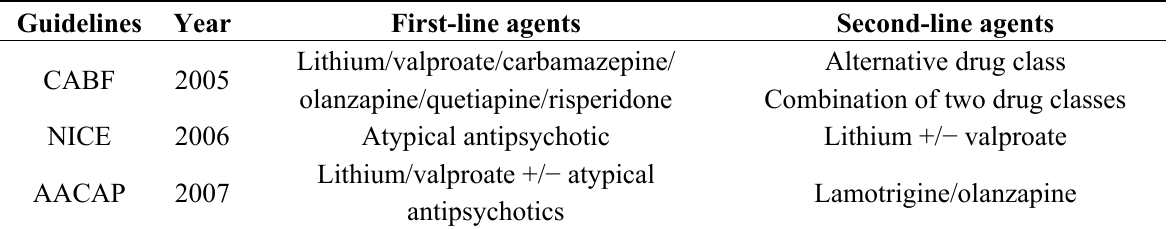
Table 1. Summary of current clinical guidelines for the pharmacological treatment of bipolar disorder in children and